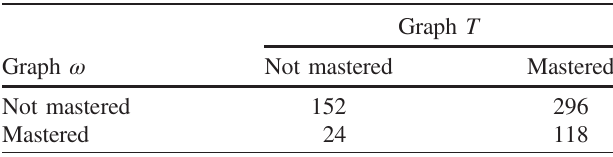
TABLE IV. Cross tabulation for the mastery of graph T and graph ω skills. Here we see indication of the hierarchy graph ω → graph T .